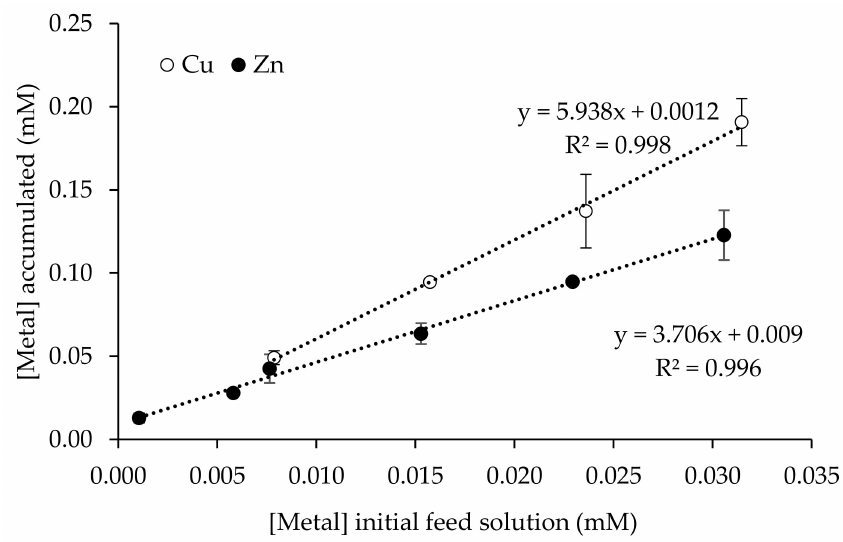
Figure 4. Effect of the initial metal concentration in the feed phase (individual studies) on metal accumulation. Feed phase: 100 mL of a 0.001 to 0.03 mM for Zn and 0.008 to 0.03 mM for Cu in